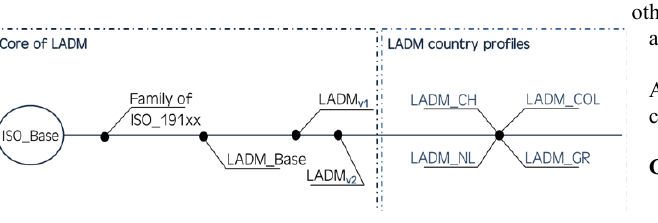
Figure 2. Stack of LADM-INTERLIS